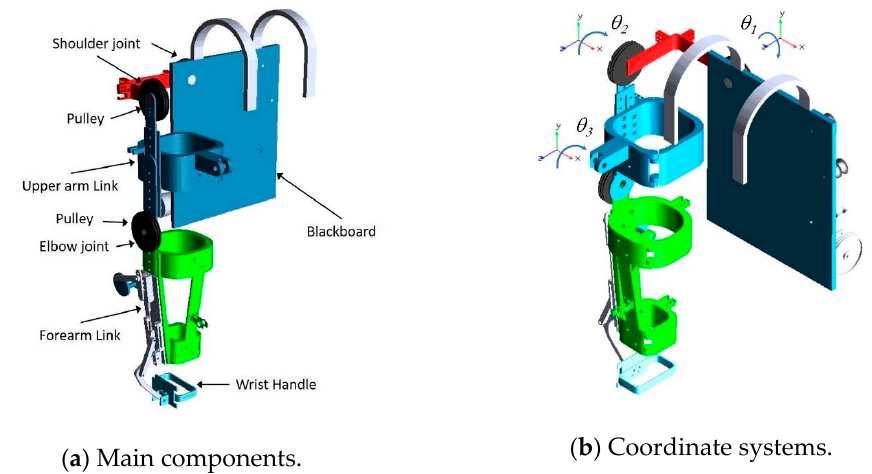
Figure 2. CAD view showing the architecture of the 3-DOF upper limb rehabilitation exoskeleton. To achieve the objective of the controller that tracks the trajectory of the exoskeleton links, a proportional-integral robust controller (GPI) based on integral reconstructs for time-dependent first-order disturbances was designed. The procedure for the controller design is the same for each of the three actuators, so the development of the controller is shown in a general way.